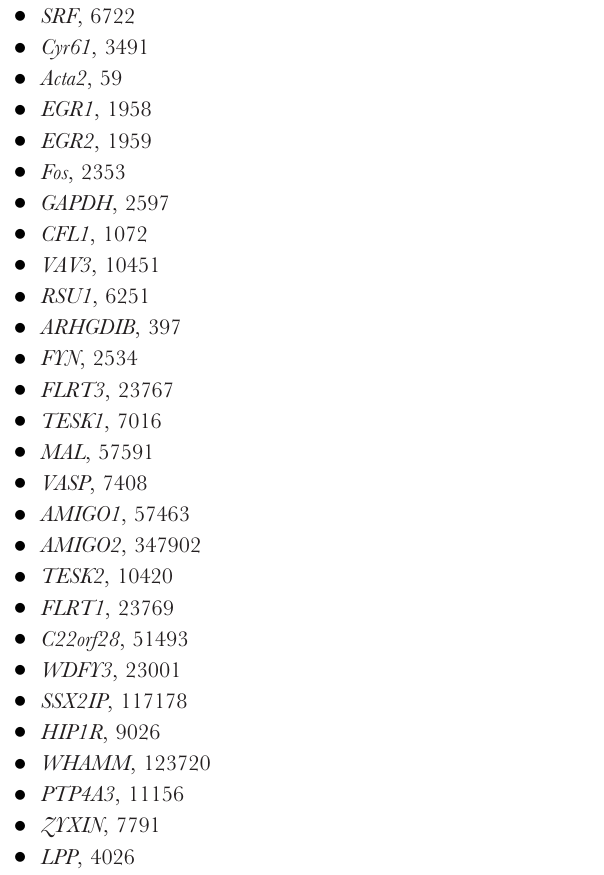
Figure S1 Transcription of a number of SRF Target genes is activated by EPEC infection. Transcription of SRF target genes measured by quantitative polymerase chain reaction (qRT-PCR). Data are the means of at least 3 experiments 6 standard deviation. Figure S2 Exogenous expression of Tir can rescue the EPEC D tir phenotype. A. MAL-GFP localization in COS-7 cells transfected with TirMC or TirMC Y474F and infected with EPEC D tir for 5 hours. Data represents the mean of three experiments, where a minimum of 150 transfected cells was counted for each condition of each experiment, 6 standard deviation. B. Anti-HA western blot confirming expression of TirMC and TirMC Y474F proteins in COS-7 cells, multiple bands are present due to host modifications of Tir.C. Vector only controls for figure 6E. TIF) Figure S3 cDNA Overexpression-induced nuclear accumulation of MAL-GFP. Immunofluorescence images of MAL-GFP locali- zation in response to overexpression of the indicated cDNAs. COS-7 cells were cotransfected with MAL-GFP and cDNA expression constructs as indicated. After 18 hours they were serum starved for 24 hours then fixed and stained. Scale bar= 20 m m. Figure S4 Knockdown of ABRA has no significant effect on FLRT3-induced MAL-GFP nuclear accumulation. Data are the means of three experiments 6 standard deviation. Figure S5 SRF localization in EPEC infected COS-7 cells. Scale bar =20 m m. Figure S6 Pedestals in ABRA knockdown cells are disorganised. Pedestal formation under microcolonies often leads to large ring structures (arrows) in ABRA knockdown cells. Found at: doi:10.1371/journal.ppat.1001332.s006 (4.23 MB